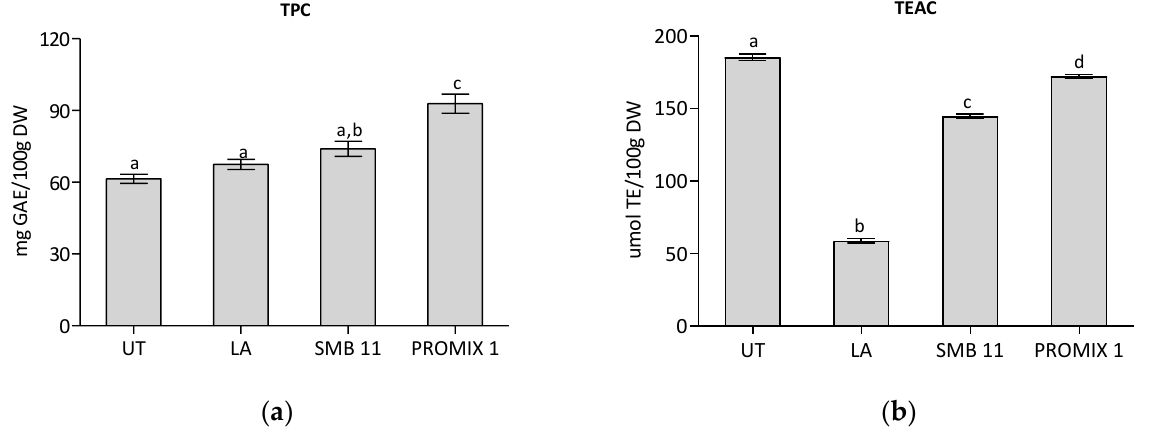
Figure 3. Total Phenol Content (TPC) and Trolox Equivalent Antioxidant Capacity (TEAC) in un- treated control (UT) and in fermented seaweed. LA: Lactobacillus acidophilus SBM-11: a mix of Lacto- bacillus sakei , Staphylococcus carnosus and Staphylococcus xylosus ; PROMIX 1: Staphylococcus xylosus . Data were submitted to one- way analysis of variance (ANOVA), Tukey’s post hoc method was ap- plied to establish significant differences among samples ( p < 0.05).